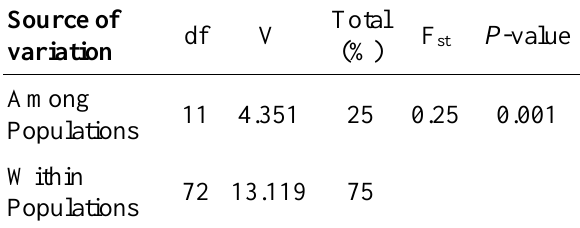
Table 3. Analysis of molecular variance